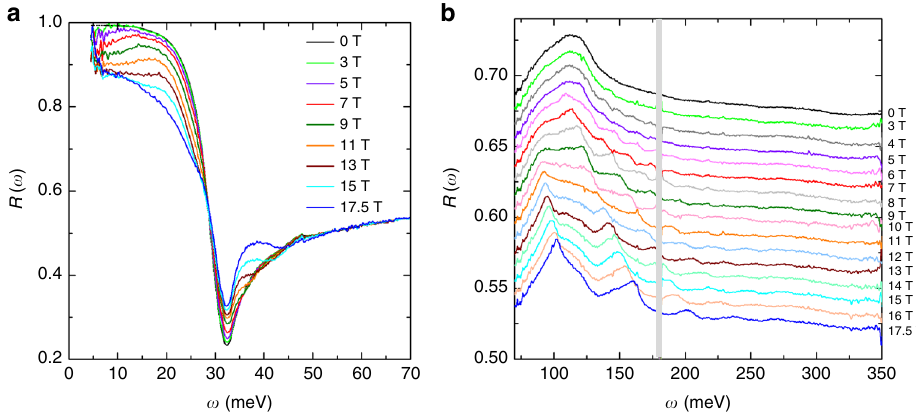
Fig. 2 IR re fl ectance spectra in magnetic fi elds. a , b Re fl ectance spectra R ( ω , B ) in several magnetic fi elds at T~4.5 K. For clarity the spectra in b are displaced from one another by 0.01 with the spectrum at B = 17.5 T shown at its actual value. The gray area around 175 meV is the energy range in which no data can be obtained due to the absorption of the optical window in